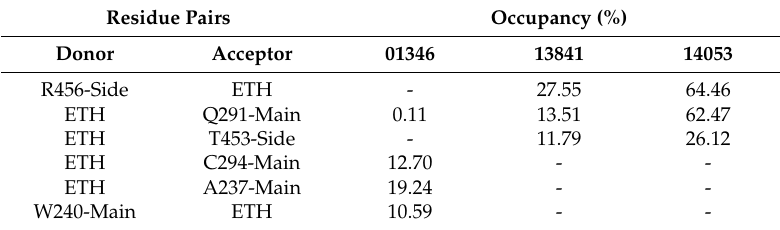
Table 3. ETH interacts stably with conformation